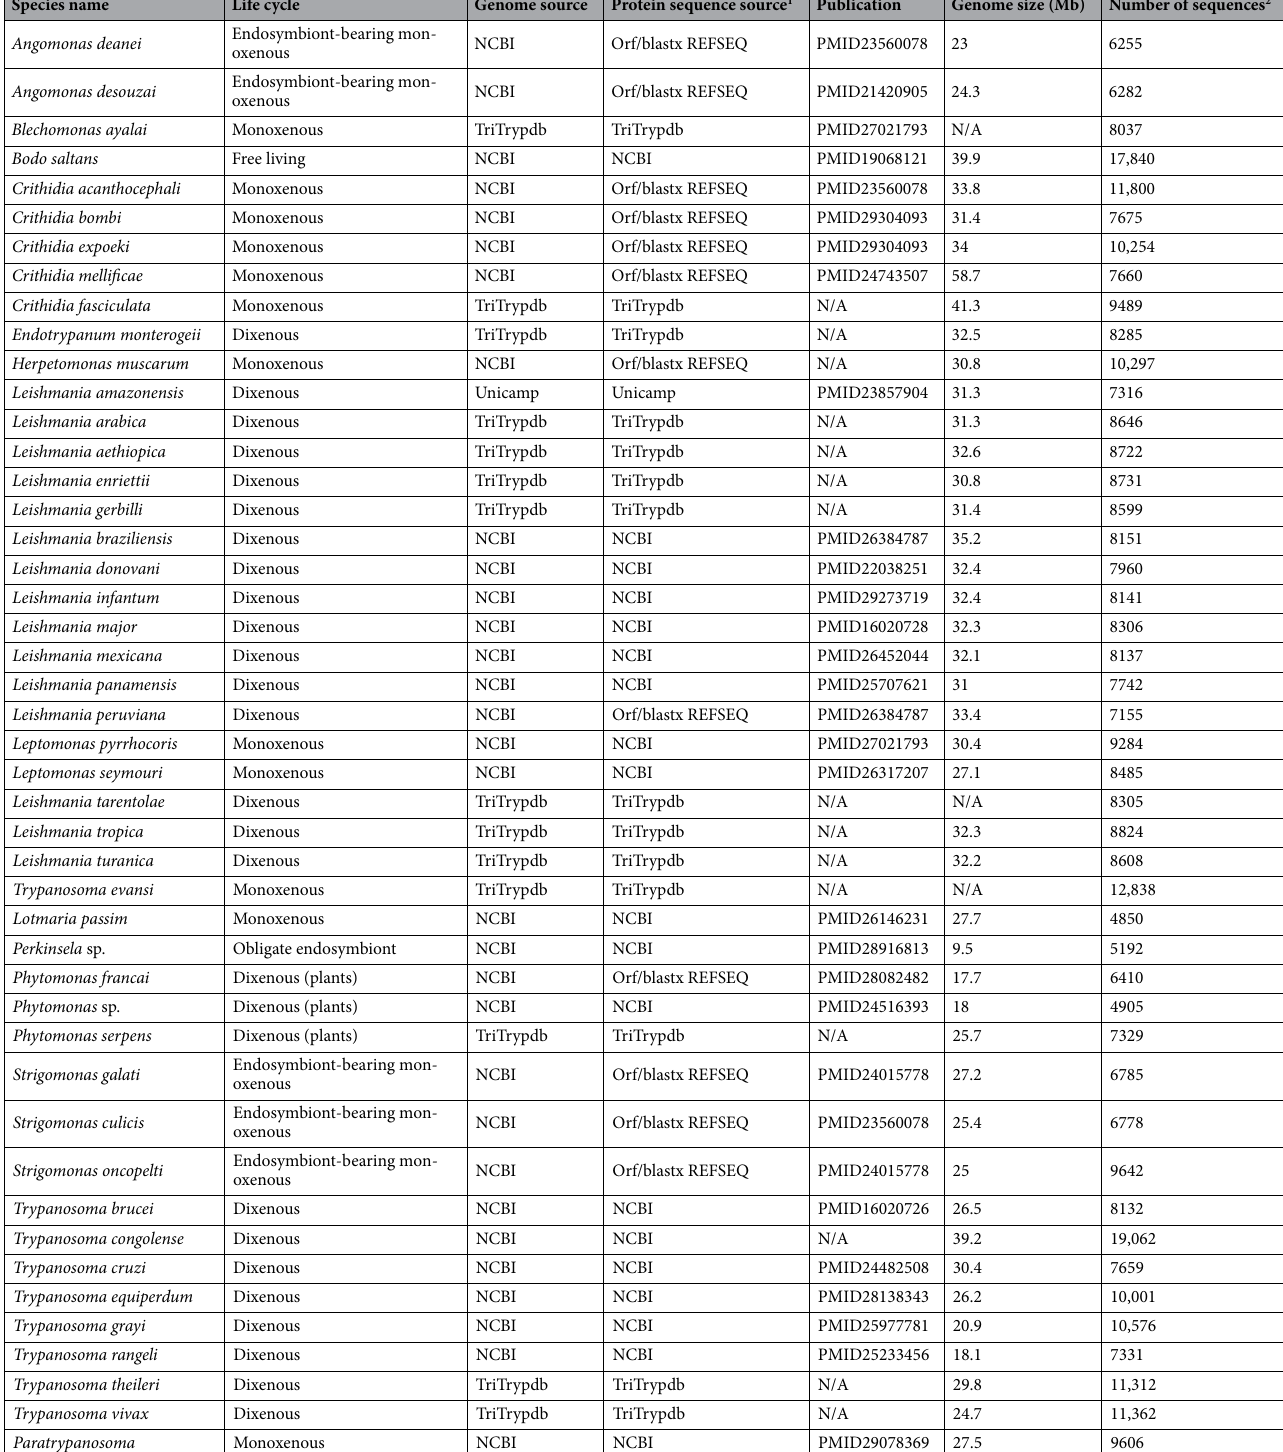
Table 1. Characteristics and source of genome-derived proteomes of kinetoplastids used in this work. 1. Protein sequences were obtained from NCBI, TriTrypDB, or deduced from genome by obtaining open reading frames and adjusting starting Met by blastx to Protozoa-Refseq NCBI database; 2. After clusterization at 99% and removal of sequences smaller than 50 aa. N/A: not